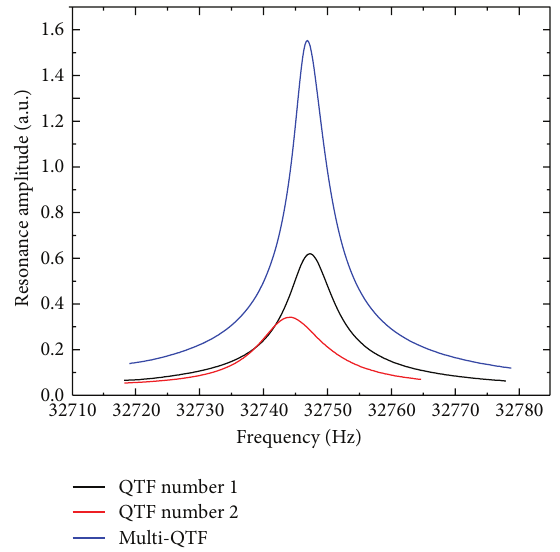
Figure 5: Resonance curves of a single bare QTF based spectro- phone and a traditional single QTF based “on-beam” spectrophone measured at atmospheric pressure in the air. Table 1: Parameters of multi-QTF based “on-beam” spectrophone (Figure 4(c)).